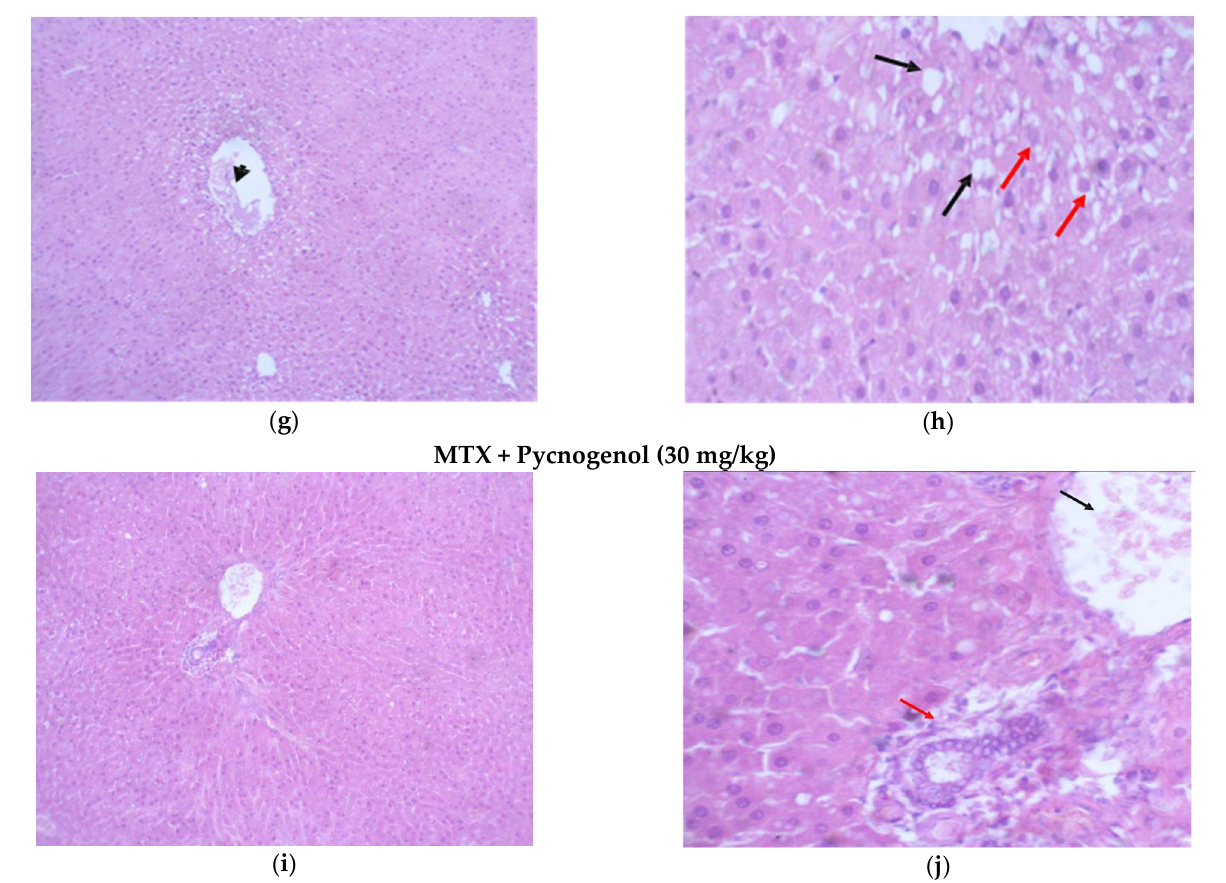
Figure 5. Photomicrograph of H&E-stained liver sections. ( a ) Normal liver architecture, with central vein (black arrow) radiating from plates of hepatocytes; separated by sinusoids (Red arrows) (H&E, 10x). ( b ) Higher magnification of hepatocytes with unremarkable pathological changes (H&E, 40x), ( c ) Multiple areas of confluent necrosis with occasional porto-central bridging necrosis (black arrows) (H&E, 10x). ( d ) Higher magnification of hepatocytes showing evidence of hepatocyte injury: fatty change (black arrows), hydropic degeneration (red arrows), and foci of lytic necrosis (arrowhead) (H&E, 40x). ( e ) Large area of confluent necrosis (black arrows) around congested central vein (arrowhead) (H&E, 10x). ( f ) Higher magnification of hepatocytes showing evidence of hepatocyte injury: fatty change (black arrows), hydropic degeneration (Red arrows), and foci of lytic necrosis (arrowhead) (H&E, 40x). ( g ) Normal liver architecture with mildly congested central (arrowhead) vein with no evidence of necrosis (H&E, 10x). ( h ) Higher magnification of hepatocytes shows the presence of mild fatty changes (black arrows) and hydropic degeneration (red arrows) (H&E, 40x), ( i ) normal liver architecture (H&E, 10x). ( j ) No evidence of hepatocyte injury. Central vein (black arrow) is shown, as well as a portal tract (red arrow) (H&E, 40x).